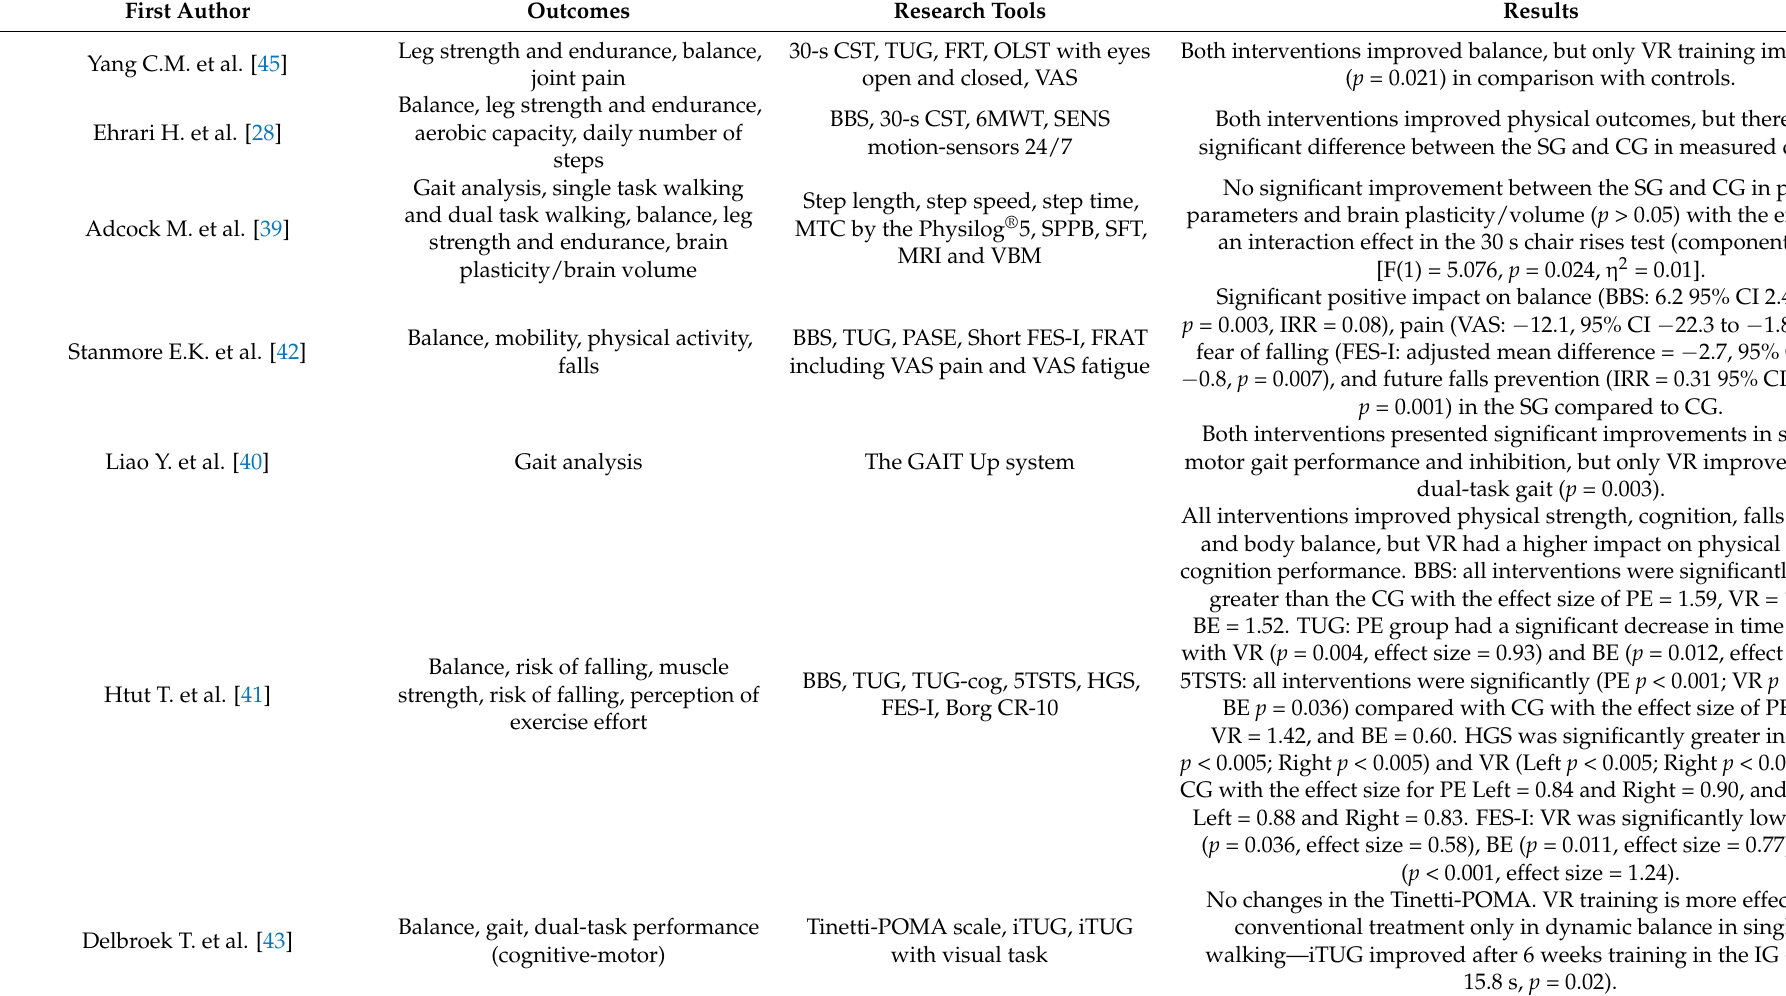
Table 2. Quantitative